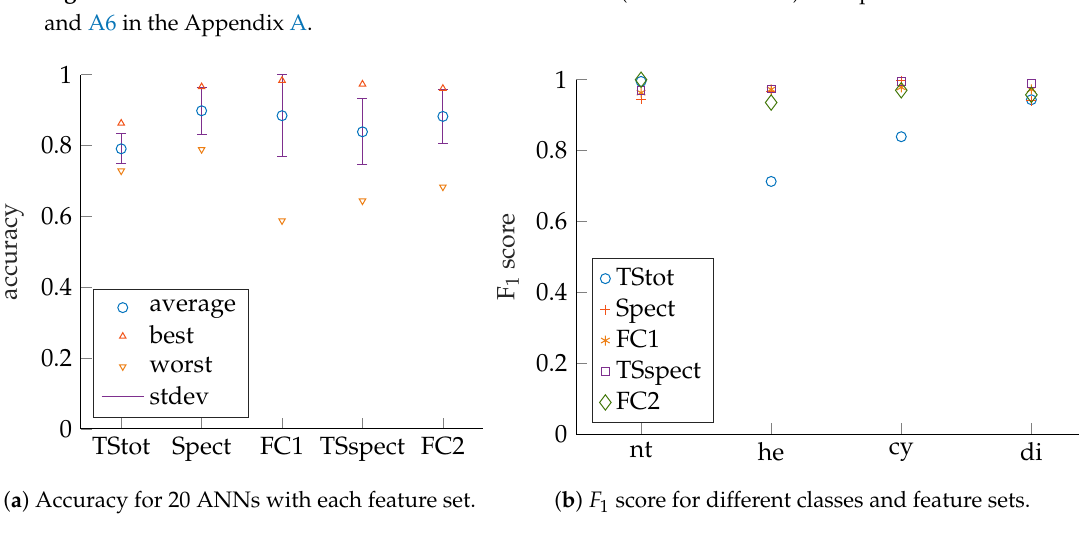
Figure 10. Performance measures for narrowband excitation (52kHz to 48kHz); grouped by shapes. Compare also Tables A7 and A8 in the Appendix